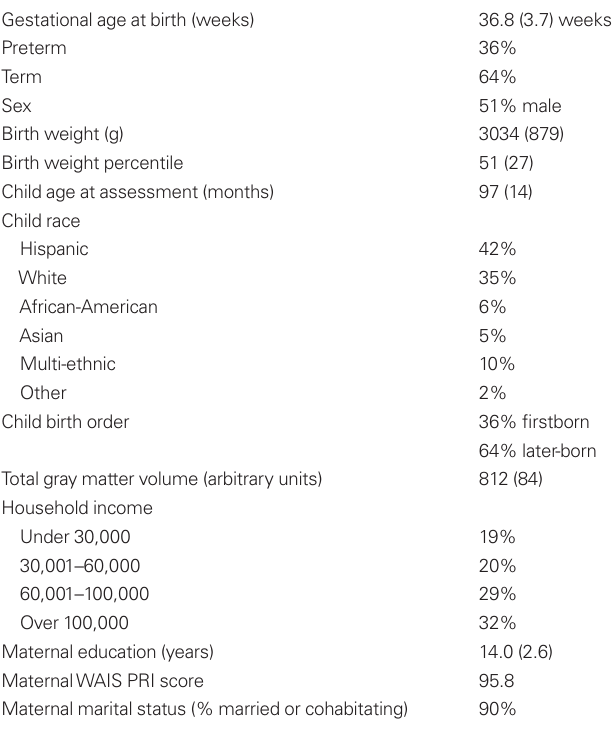
Table 1 | Birth outcome, demographic, and neurodevelopmental characteristics of the study